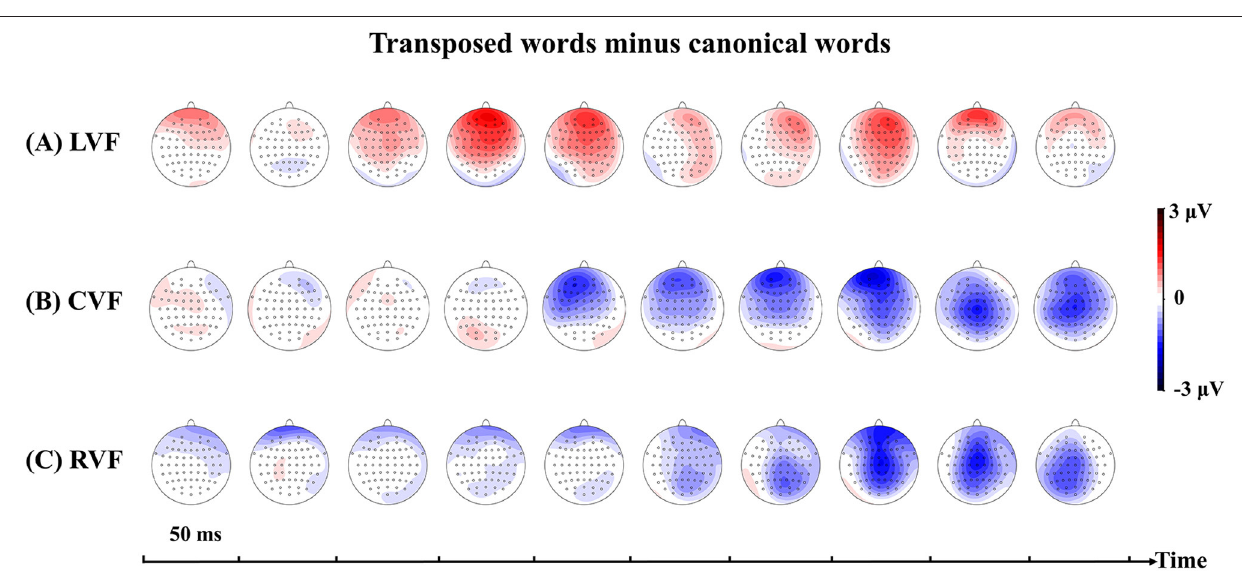
transposed words at the anterior site ( p < 0.05), but not at the posterior site ( p > 0.05). No differences were found for CVF or RVF presentations (all ps >